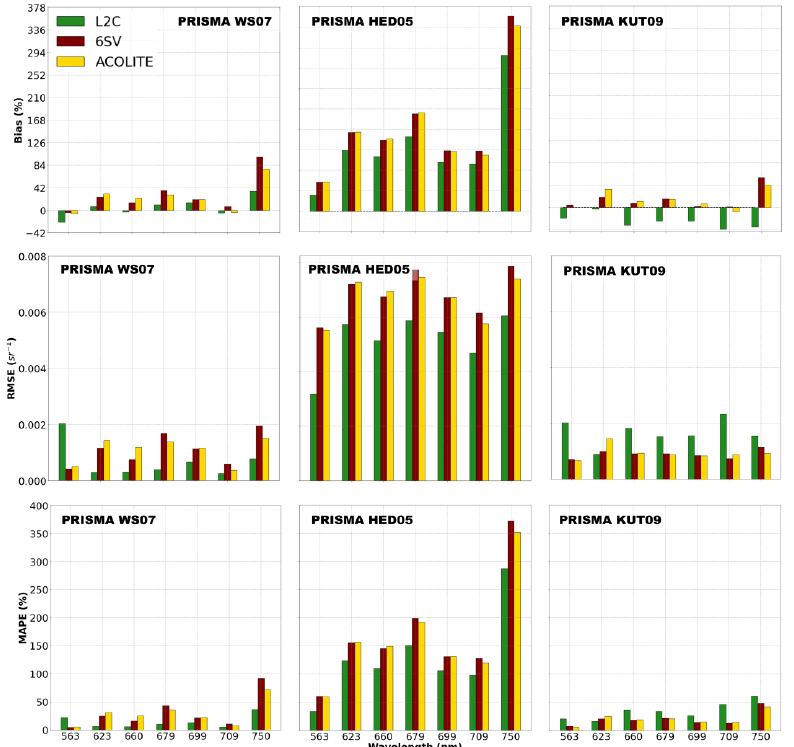
Figure 5. Plots of the median spectral statistic (bias, RMSE, and MAPE) for the three glint correction methods (Wang and Shi (2007), Hedley (2005) and Kutser (2009)) for 3 October 2021 for the most critical wavelengths used in the PC models.